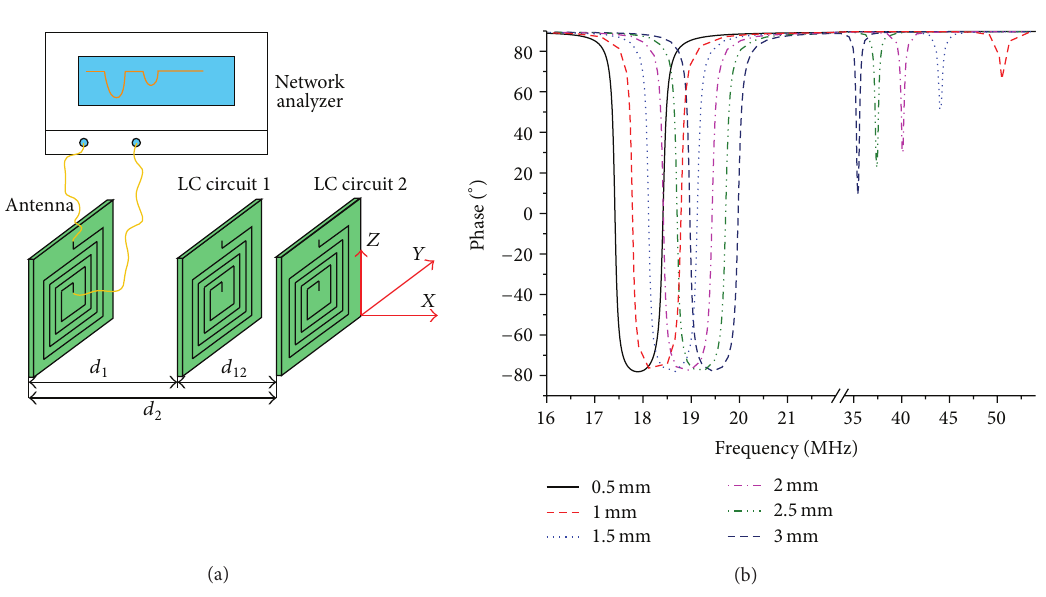
Figure 12: (a) Relative position of three coils. (b) Test